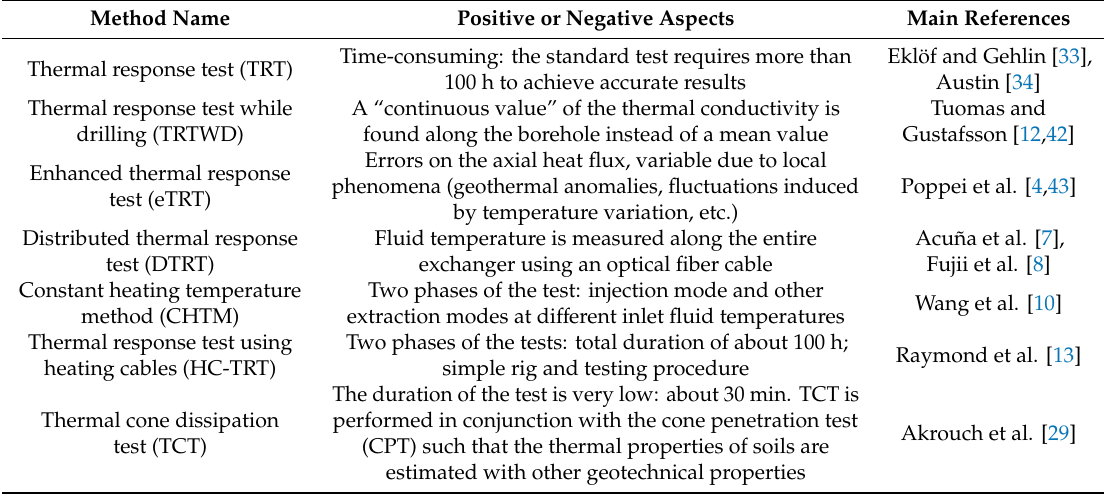
Table 1. TRT methods that are available: nomenclature and